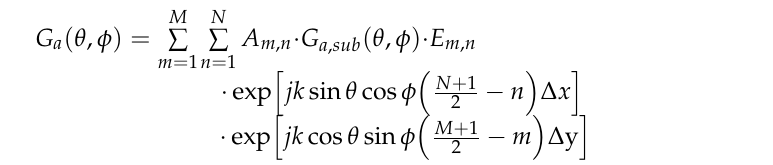
( b ) Figure 20. Antenna patterns of the S-STEP SAR payload in ( a ) azimuth and ( b ) elevation.